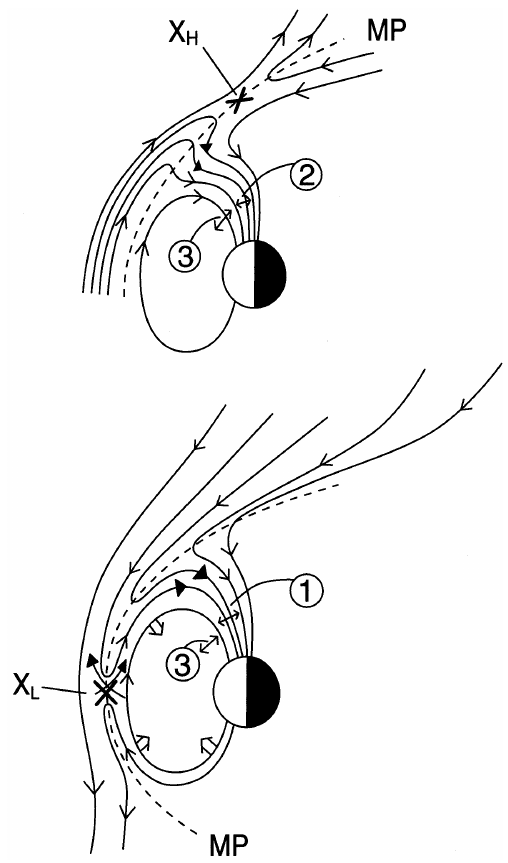
Fig. 4. Schematic illustration of magnetosheath-magnetosphere in- terconnection geometry for northward (top panel); and southward IMF